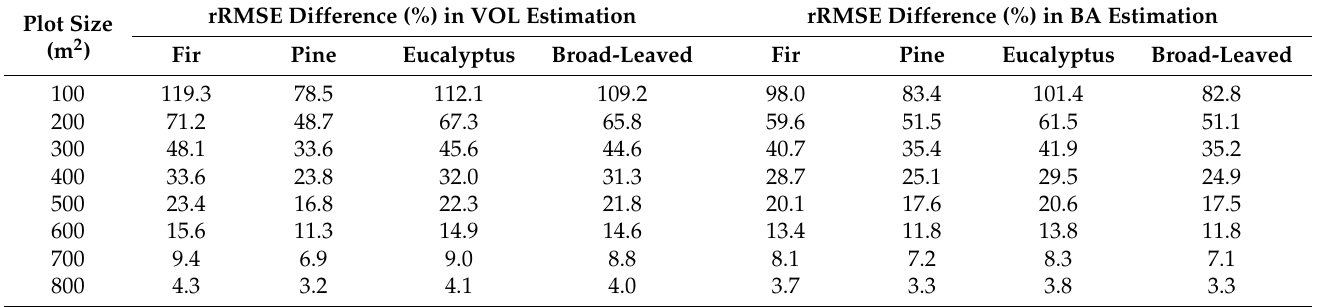
Table 6. Theoretical difference (%) of rRMSEs between plots of different sizes and the 900 m 2 plots calculated from the rRMSE plot size regression models in VOL and BA estimation in four forest